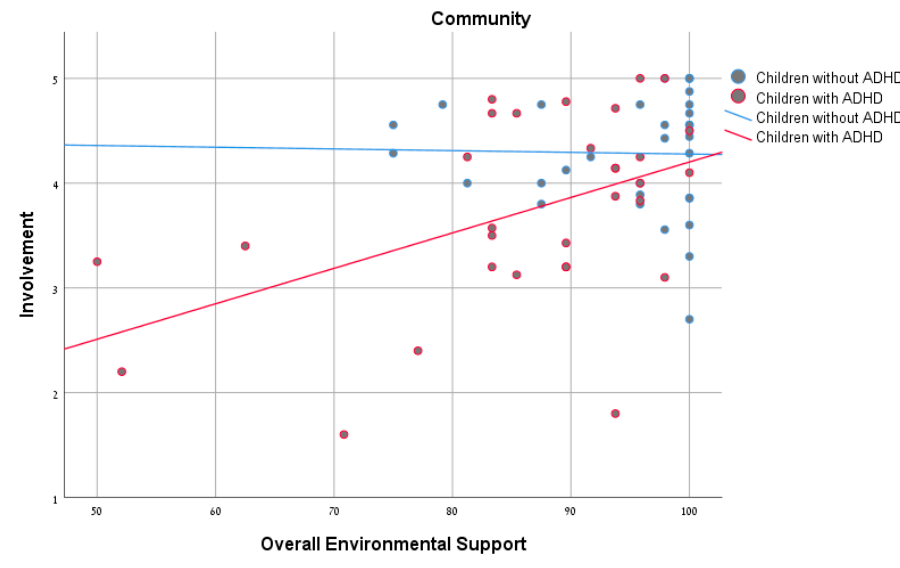
Figure 3. Correlations between overall environmental support and involvement among children with and without ADHD in the community environment.